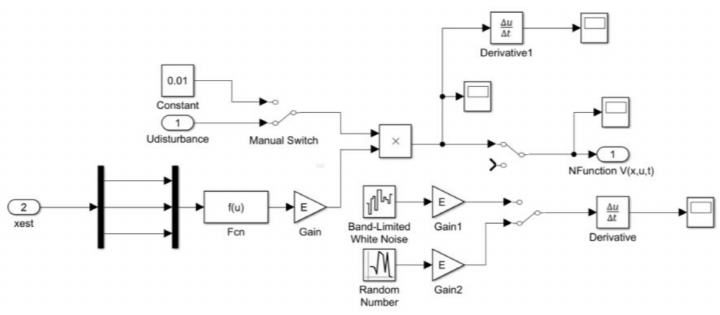
Figure 31. The Simulink model of the disturbance and noise generator.